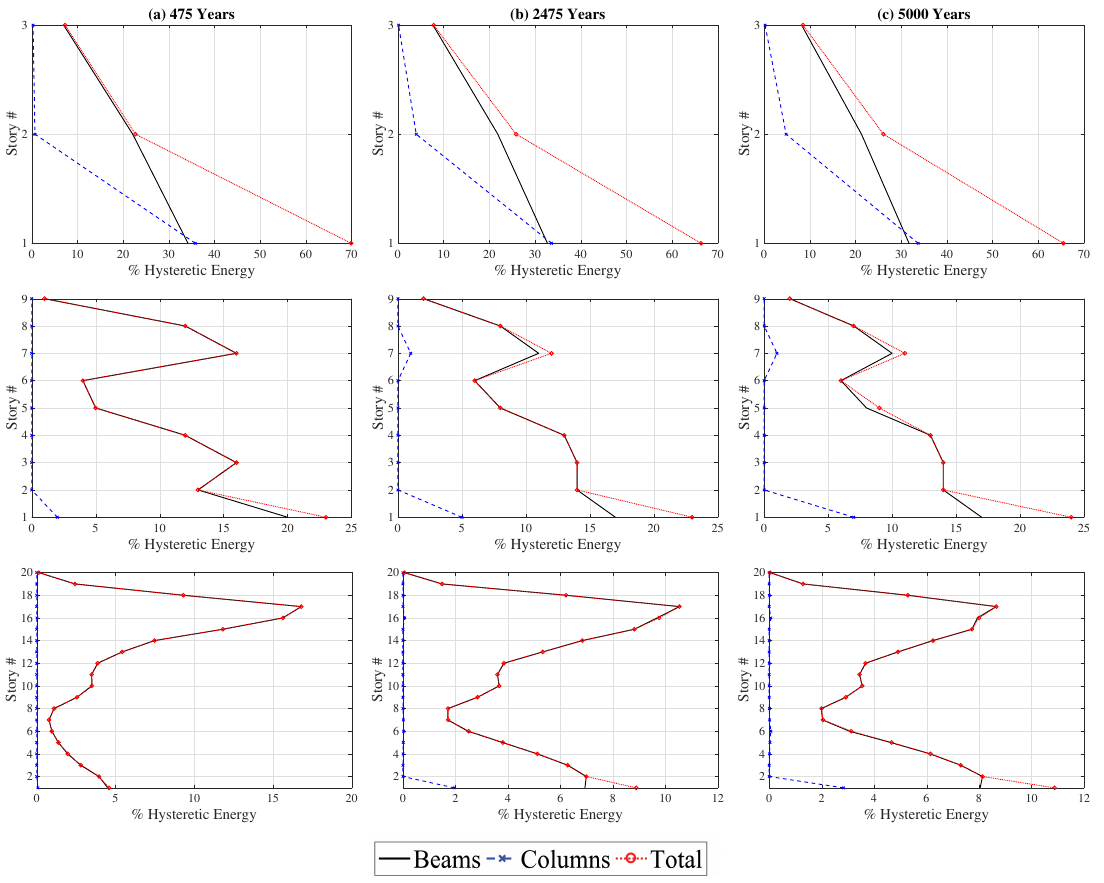
Figure 5. Median hysteretic energy demands over the height of the buildings for ( a ) 10/50, ( b ) 2/50 and ( c ) 1/50 sets.